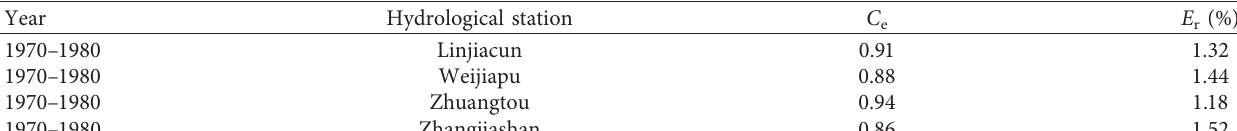
Figure 4: Calibration results of hydrometric stations. (a) Linjiacun station. (b) Weijiapu station. Table 3: The simulation results during the validation period.